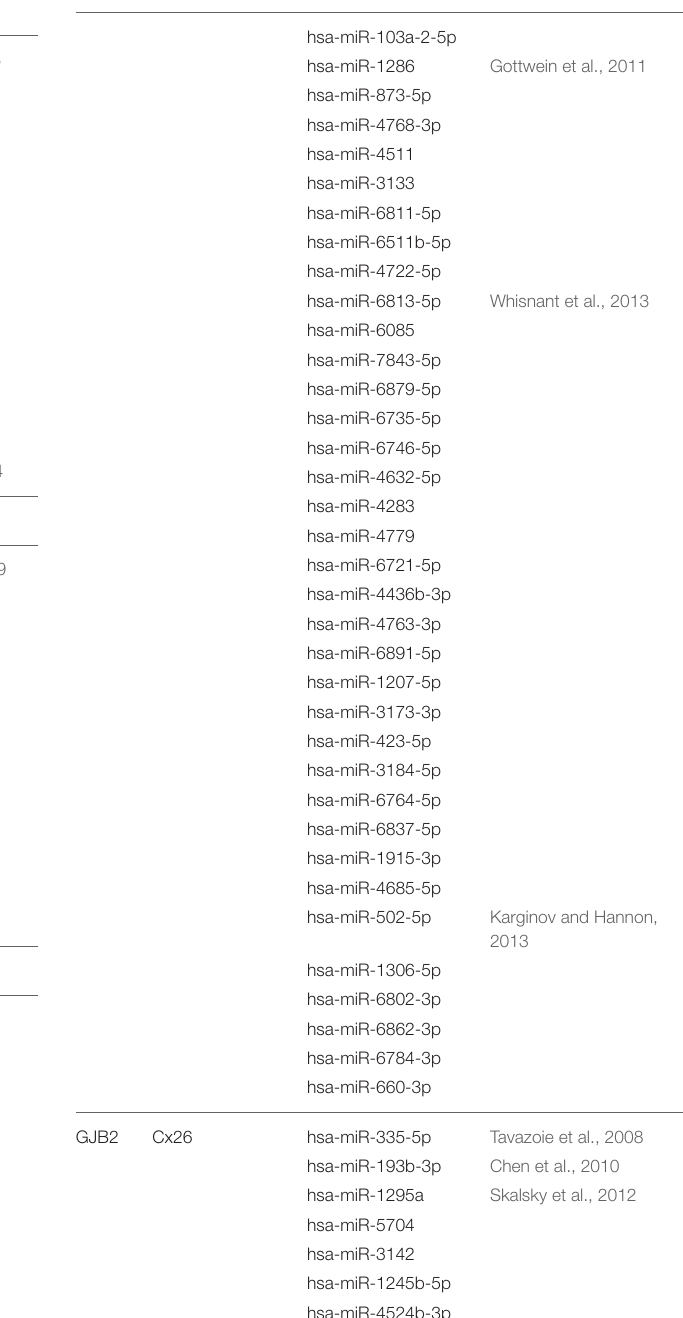
TABLE 1 | Detailed list of miRNAs predicted to target the different connexin genes, as demonstrated in the associated reference.